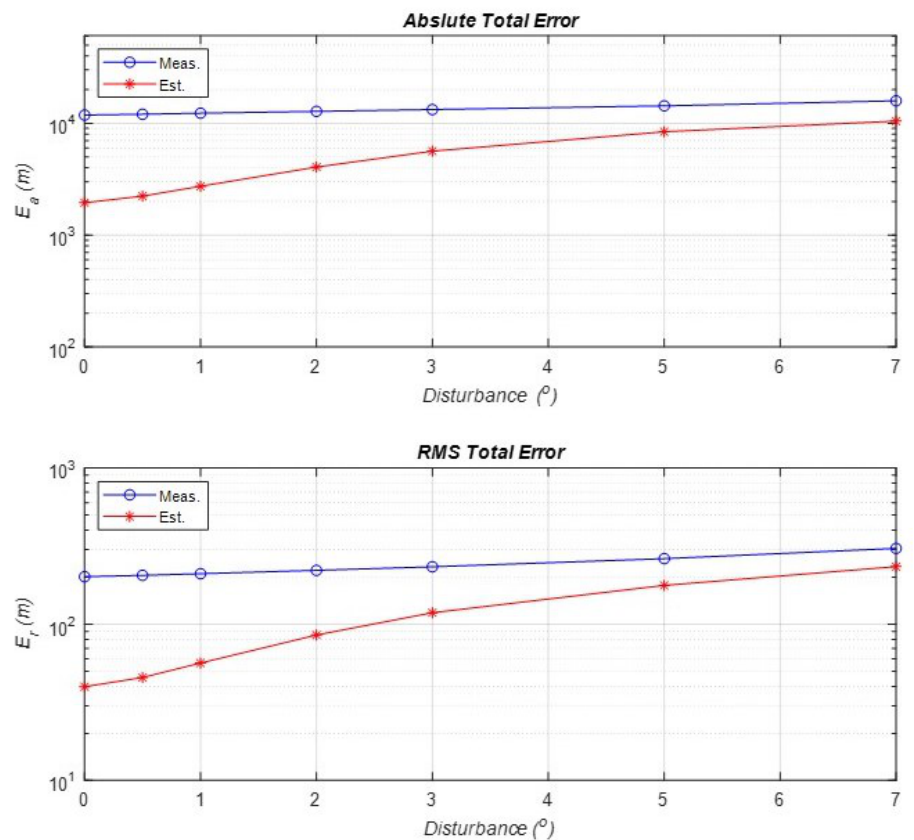
Figure 11. Absolute and RMS total measured errors (blue lines), and absolute and RMS total estimated errors (red lines) related to the external-disturbance effect to the oscillation of the sea-surface vehicle at constant grid range and beam